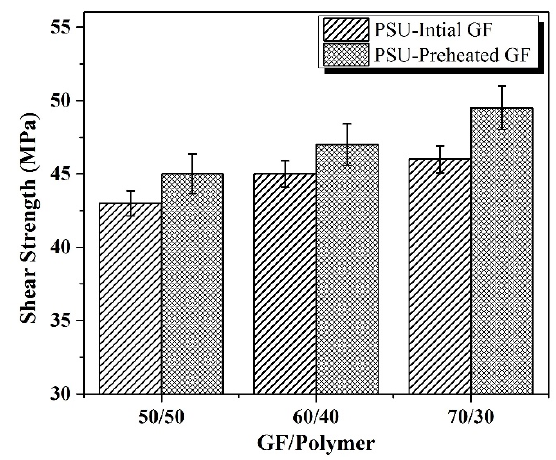
Figure 4. Shear strength for the initial GF and the preheated GF reinforced composites.